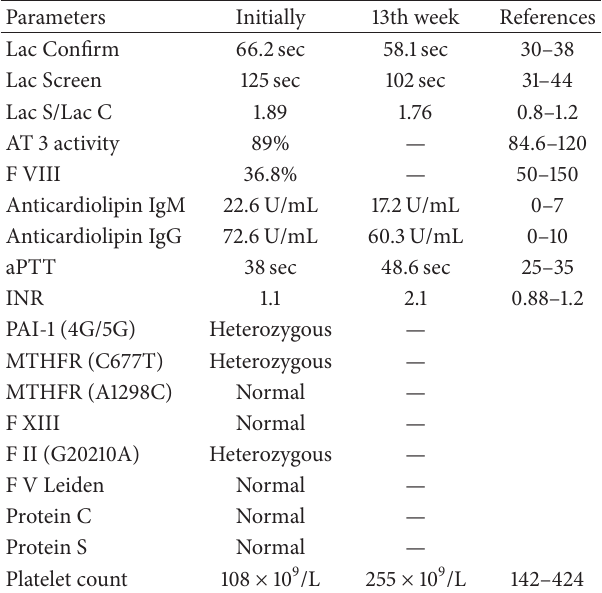
Figure 2: PTE was detected on the right main pulmonary artery and left pulmonary artery branches and consolidation areas in bilateral lower lobe and areas of ground glass in the upper and lower lobes in computed tomography pulmonary angiography. Table 1: Thrombophilia panel of